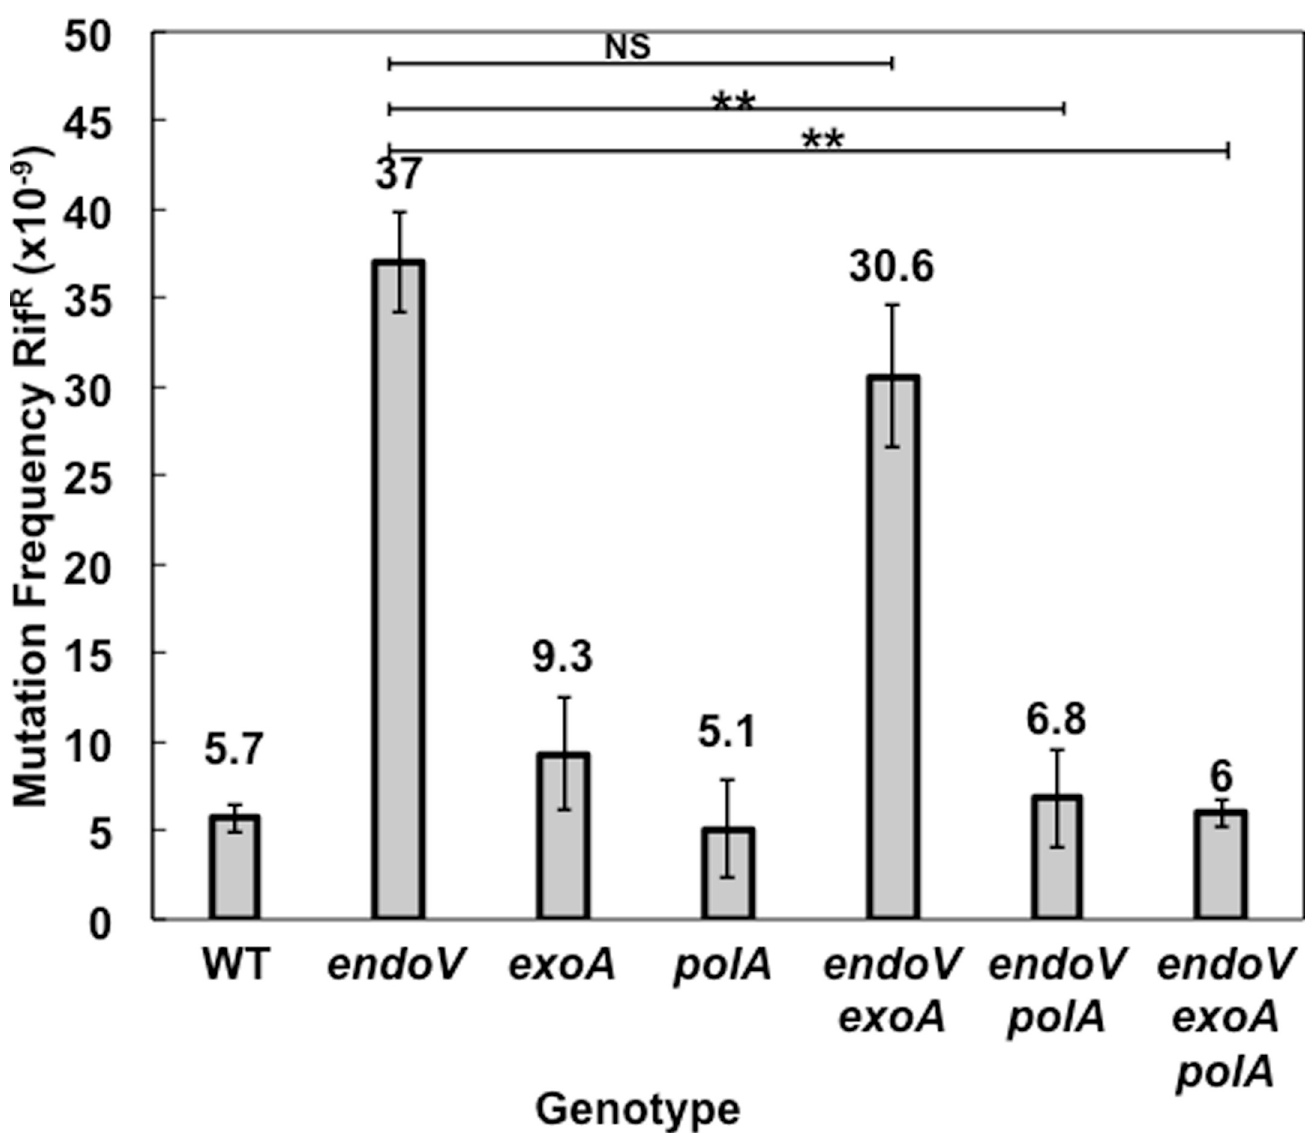
Fig 7. Frequencies of spontaneous mutation to Rif r in cells of various B . subtilis strains. Cells of B . subtilis WT, endoV , exoA , polA , endoV exoA , endoV polA and endoV exoA polA strains were cultivated in liquid PAB medium, and spontaneous mutation frequencies to Rif r were determined as described in Methods. Results represent the mean of three independent experiments. Error bars indicate the standard error of the mean (SEM). �� , P < 0.01 (by the Mann-Whitney U test). NS, non